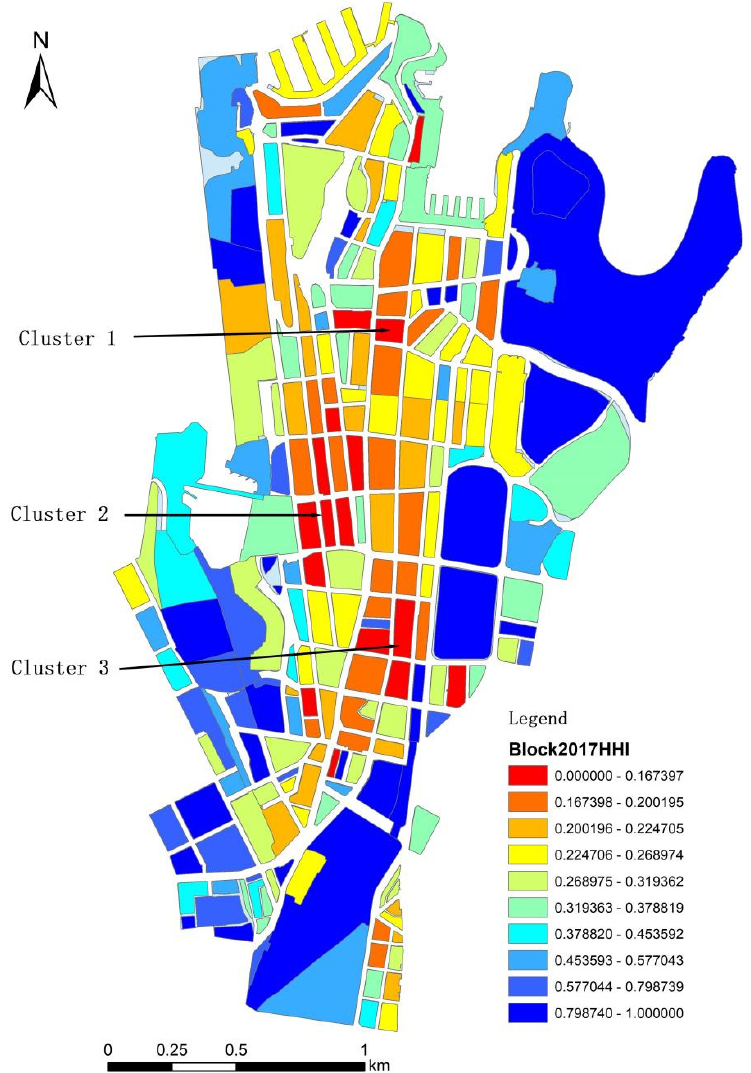
Figure 2. Heterogeneity of urban blocks in 2017 (red colour, higher mixed-use land). Note: the natural break algorithm was used to define and visualise ten classes of HHI. Urban blocks with brighter colour (red) had low HHI, which means a higher heterogeneity within the blocks. Three clusters emerged in this analysis: one is around the Wynyard station (cluster 1), one is to the west of the town hall station (cluster 2), and the third is around the museum station, to the west of Hyde Park (cluster 3).